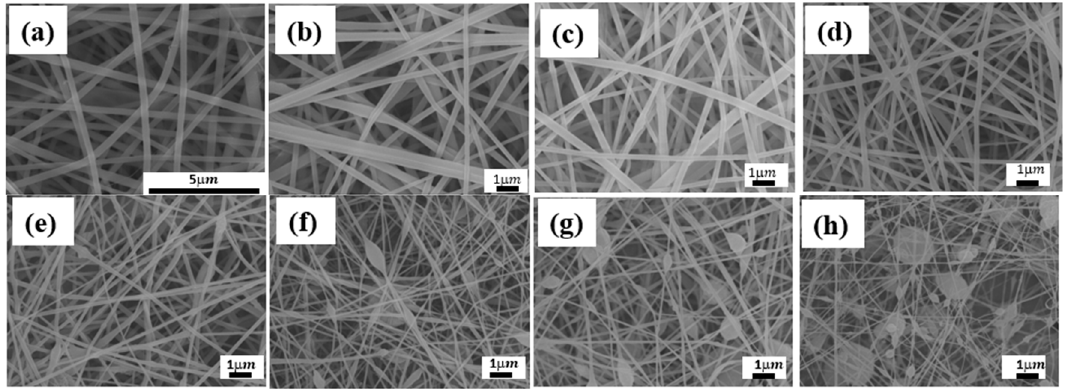
Figure 3. SEM images of SF nanofibers with different added amounts of PANI: ( a ) 0%, ( b ) 2.5%, ( c ) 5%,